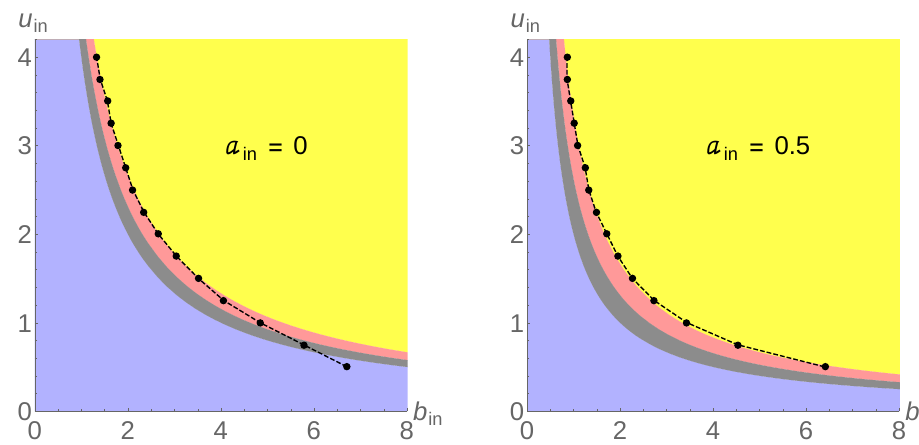
Figure 5 . Outcome of symmetric collisions of two black holes with initial spin, velocity, and impact parameter ( a in ; u in ; b in ). The dots (joined by dashed lines) separate between initial conditions that lead to: (i) (below the dots) 2 ! 1 events of fusion into a stable object; or (ii) (above the dots) 2 ! 1 ! N cosmic-censorship-violating (cid:12)ssion events, or fusionless 2 ! 2 events. The colors distinguish between the stable phases available (same color coding as in (cid:12)gure 3). For small enough b in and u in (below the dots) the system always settles down into the available stable single blob, but for larger b in and u in (above the dots) there is either no available stable phase (yellow region), or if there is, the dynamical evolution passes too far from